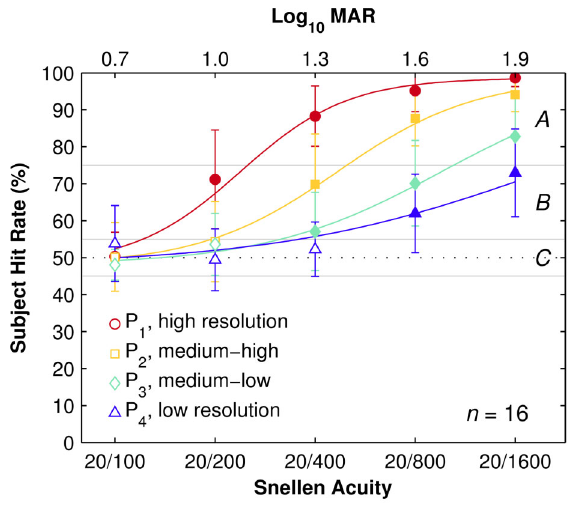
Figure 5. Hit rate results. Hit rate as function of font size, grouped by pattern resolution. For each condition, symbols indicate population mean and error bars, standard deviation. Each trace represents the fitted curves of subject hit rate for each pattern resolution (mean deviation below 1.2%). Font size is shown on the horizontal axis. Filled symbols are significantly above chance. The letters A , B , and C indicate the High-Performance, Mid-Range, and Chance/Low-Performance ranges, respectively (see main text). Subjects were not significantly above chance for all phosphene patterns for the smallest optotypes (F 1 , Snellen 20/100), with population hit rate increasing with both pattern resolution and optotype size.